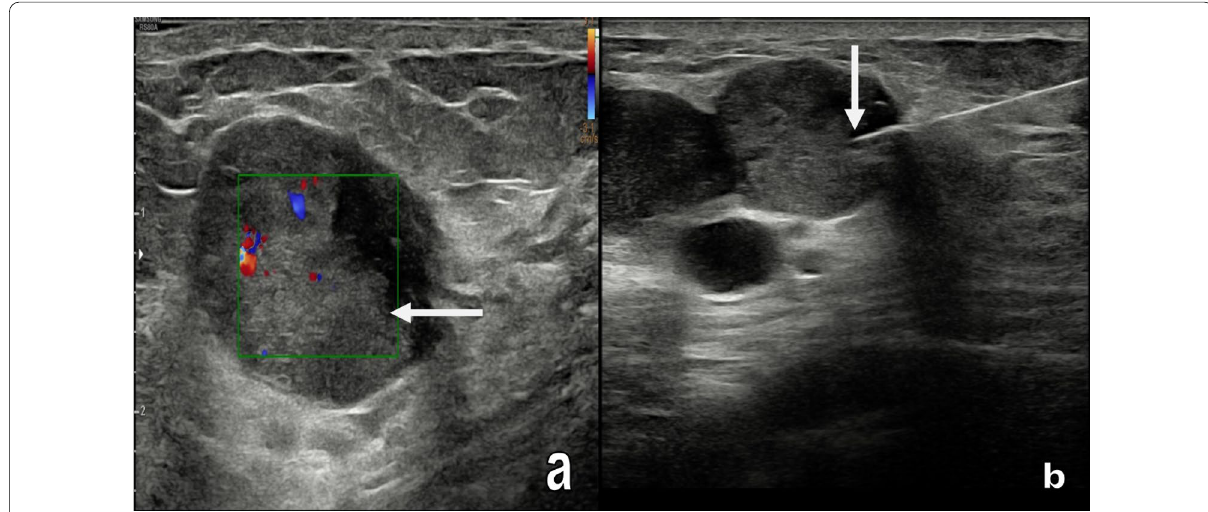
Fig. 4 Ultrasound images showing type 4 complex cyst with vascularity on color Doppler ( a ) and biopsy needle seen inside the lesion ( b )